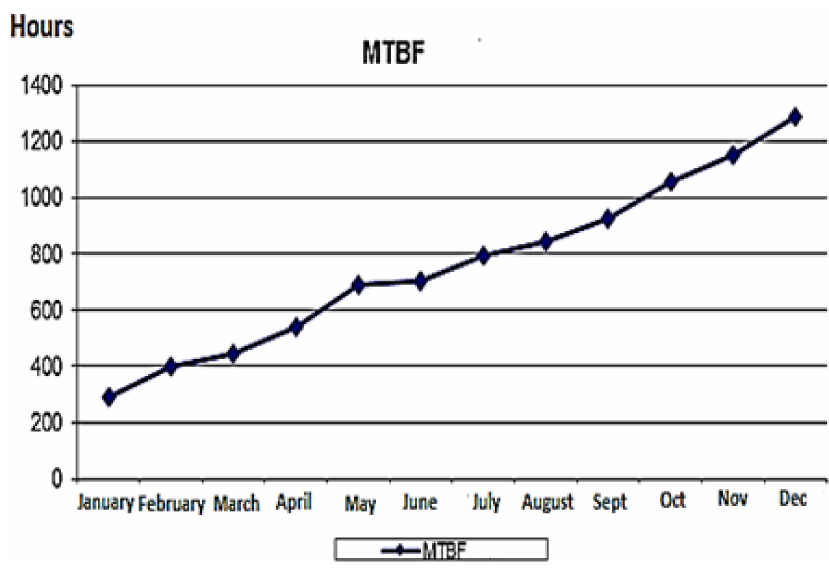
Figure 14. MTBF results indicators for the year 2016.